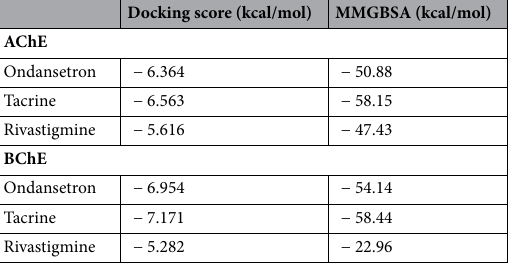
Table 2. Data from docking analyses and free energies of binding of different ligands for both receptor